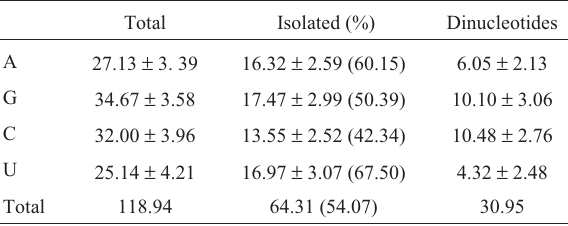
Table I - Isolated and clustered bases in 5S